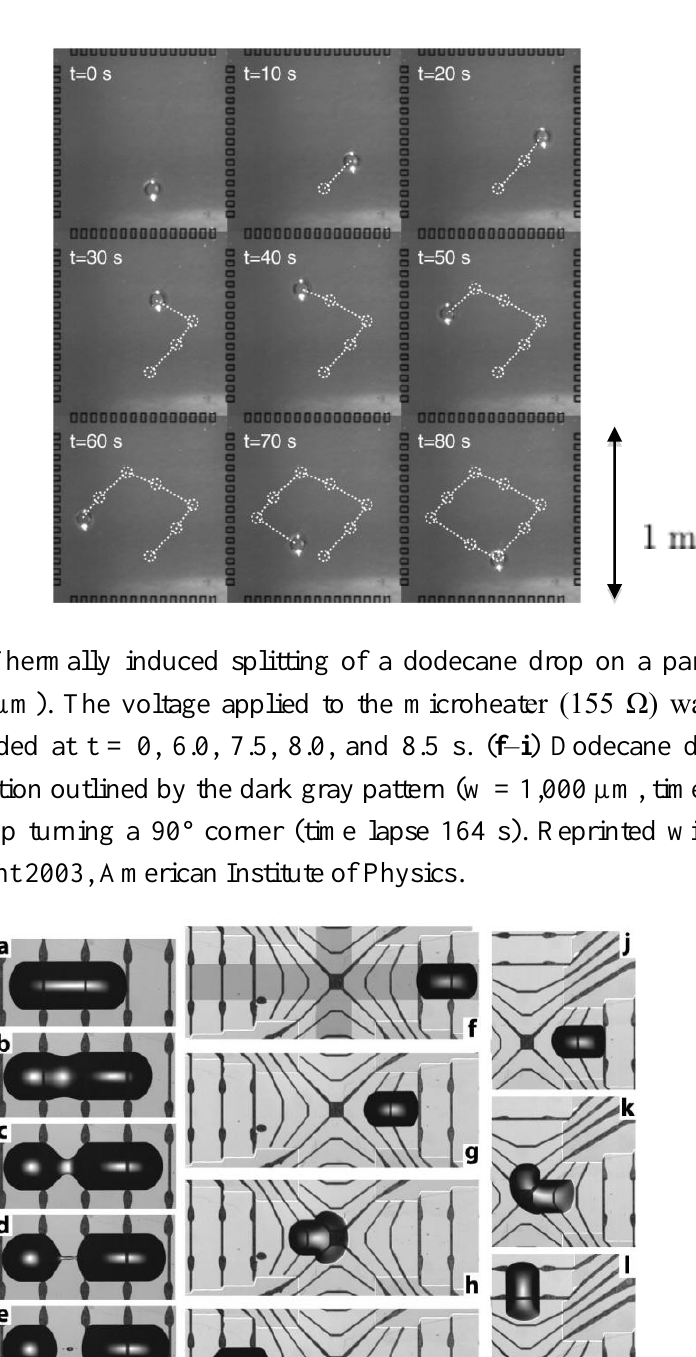
Figure 18. Succession of droplet positions by spatially varying the temperature gradient in time, (duration 80 s). Reprinted with permission from [21]. Copyright 2008, Institute of Physics.